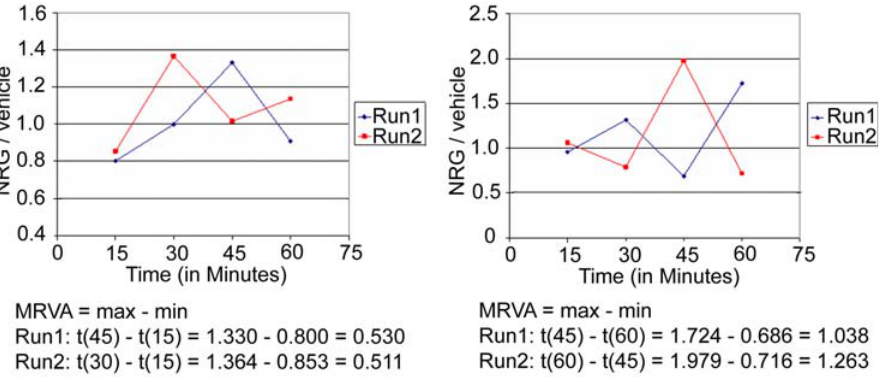
Figure 1. Neuregulin-1 induces temporally varying cell adhesion that appears characteristic of a particular cell line. In response to NRG1 a stimulation over time, cells of a given cell line as a population fluctuate between states of relative detachment and states of relative attachment. In order to test the reliability of these patterns, ten cell lines on two separate days were tested using our adhesion assay. Two representative examples are shown. While the timing of peaks and troughs varied between runs, the maximum range of varying adhesion (MRVA) was remarkably consistent (p=0.016). Calculation of the MRVA for each run of each cell line is shown.